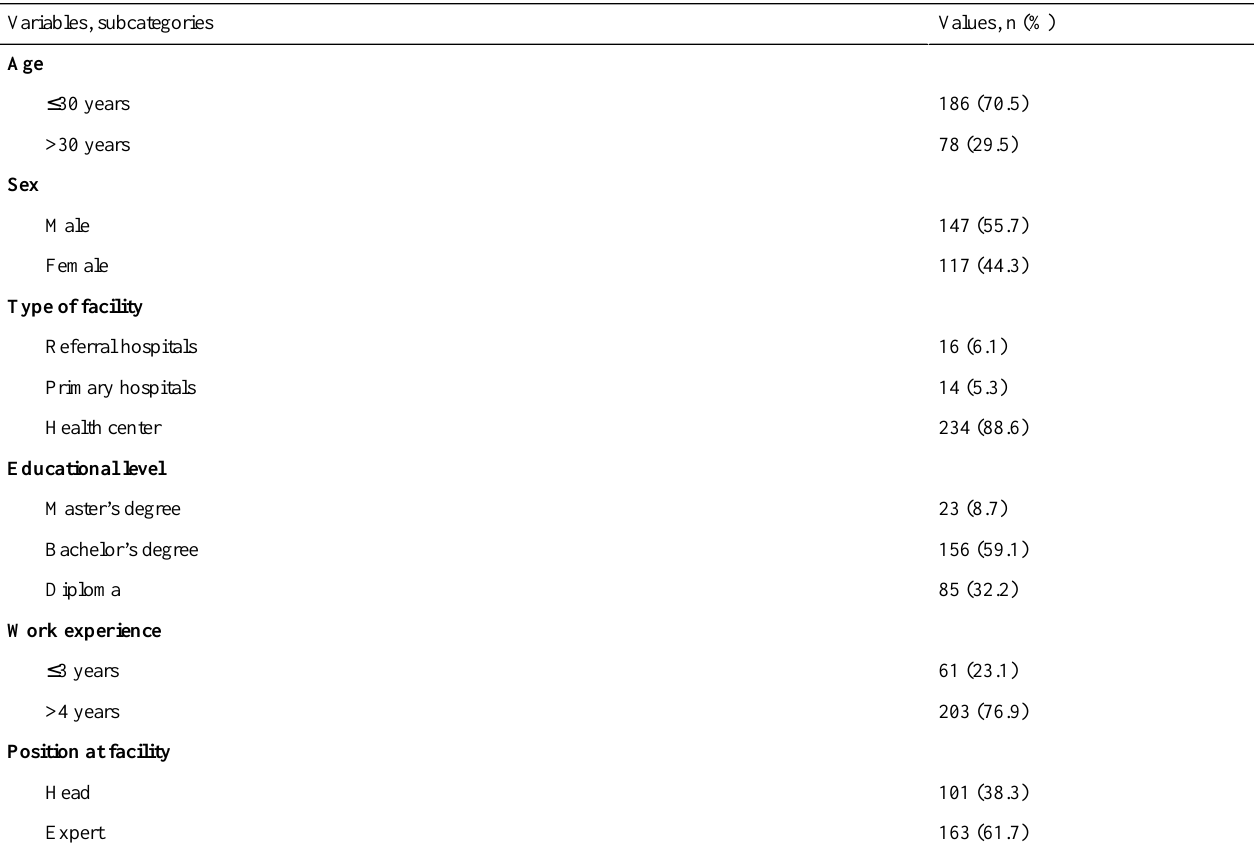
Table 1. Sociodemographic characteristics of the study participants at the health facilities of Ilu Aba Bora Zone in 2020